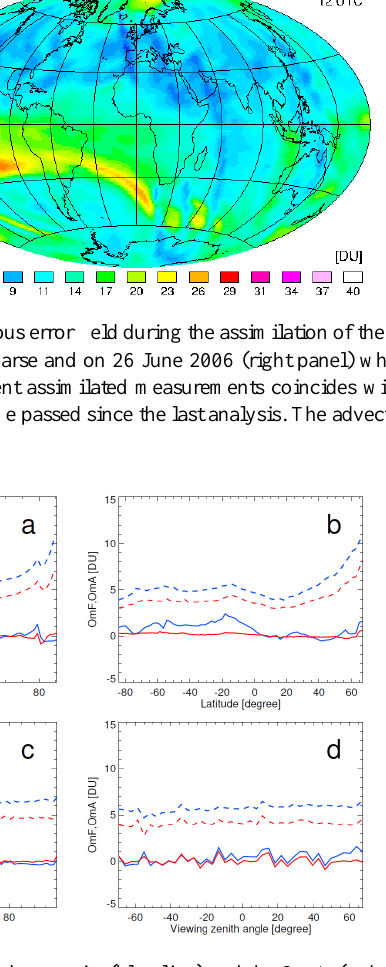
Figure 6. The OmF in Dobson units (blue line) and the OmA (red line) as a function of solar zenith angle (a) , latitude (b) , cloud frac- tion (c) , and viewing zenith angle (d) . The dashed lines represent the RMS value of the OmF (blue) and the OmA (red) distribution. All data are averaged over January 2008.